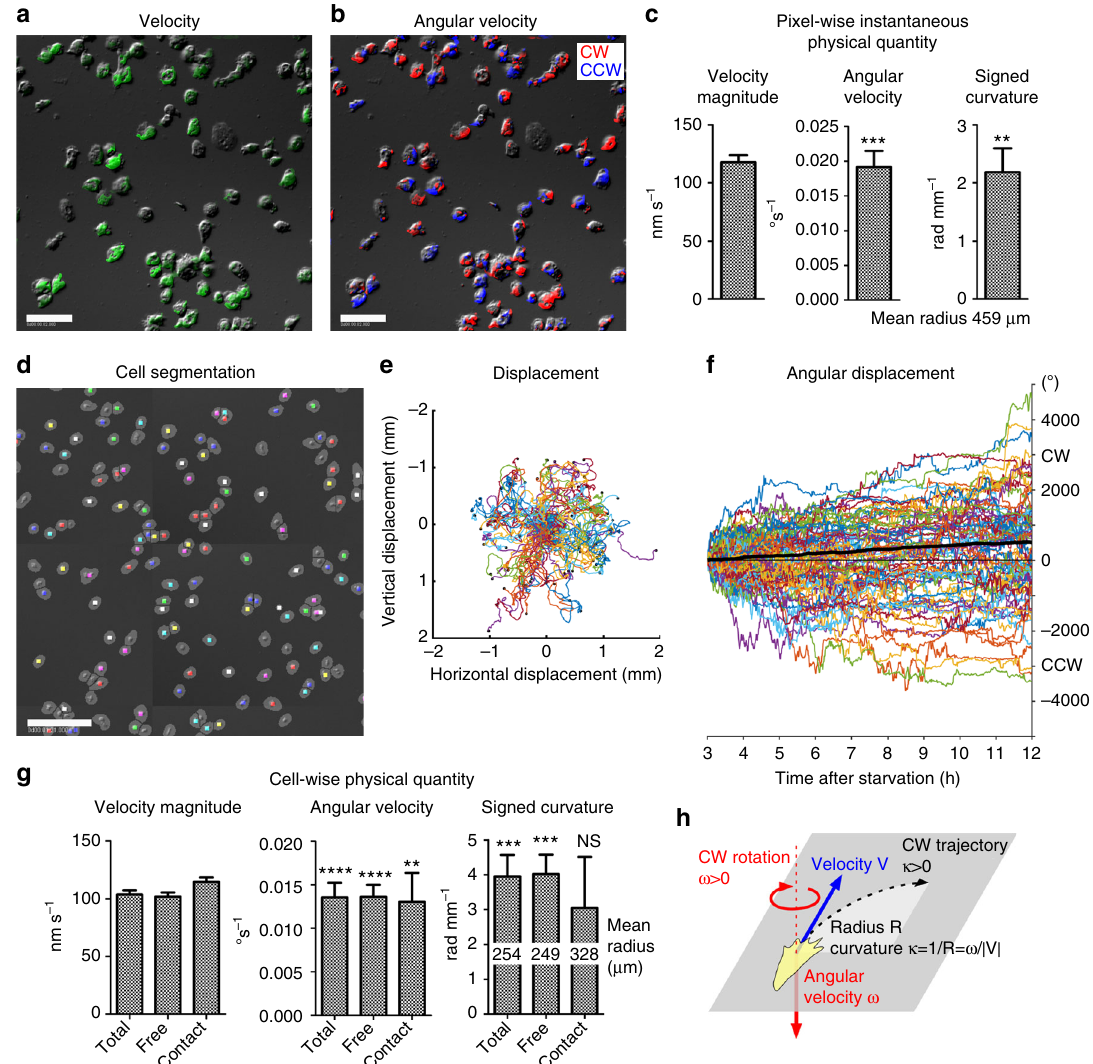
Fig. 6 Motility analysis of Dictyostelium cell migration on 2D surface. a – c Pixel-wise analysis of single- fi eld (330 × 330 μ m) images from short-term (3 – 4 h after starvation; HAS) imaging of high-density (1 × 10 5 cells per cm 2 ) cultures. a Raw DIC image (gray) of cells at 3 HAS is overlaid by pixel-wise instantaneous velocity magnitude (green). b Distribution of angular velocity. Positive (red) and negative (blue) values represent clockwise (CW) and counterclockwise (CCW) rotation, respectively. Data from high-density culture #1 ( a , b ). c Summary of pixel-wise instantaneous physical quantities. The values represent mean ± s.e.m. of the means for individual cultures ( n = 6). ** P < 0.01, *** P < 0.001. One sample t -test for the null hypothesis that the mean is equal to zero. d – g Cell tracking analysis of multi- fi eld (3.1 × 3.1 mm) stitched images from long-term (3 – 12 HAS) imaging of low-density (1 × 10 4 cells per cm 2 ) cultures. d Example of segmentation and tracking of cells at 7.68 HAS. Raw DIC image (gray) and smoothed RT-DIC images that were segmented into cell particles by watershed transform (gray ovals) are overlaid by optical fl ow-tracked cell centroids (seven different colors). e , f displacements e and angular displacements f for all tracked cells ( n = 625) during 3 – 12 HAS. The mean angular displacement (black bold line) shows constant clockwise bias. Data from low-density culture #1 d – f . g Summary of cell-wise physical quantity. The quantities are collected in total frames or in the presence or absence of contacts with other cells. The values represent mean ± s.e.m. of the means for individual cultures ( n = 8). ** P < 0.01, *** P < 0.001, **** P < 0.0001, NS, P > 0.05. One sample t -test for the null hypothesis that the mean is equal to zero. h Rightward-biased